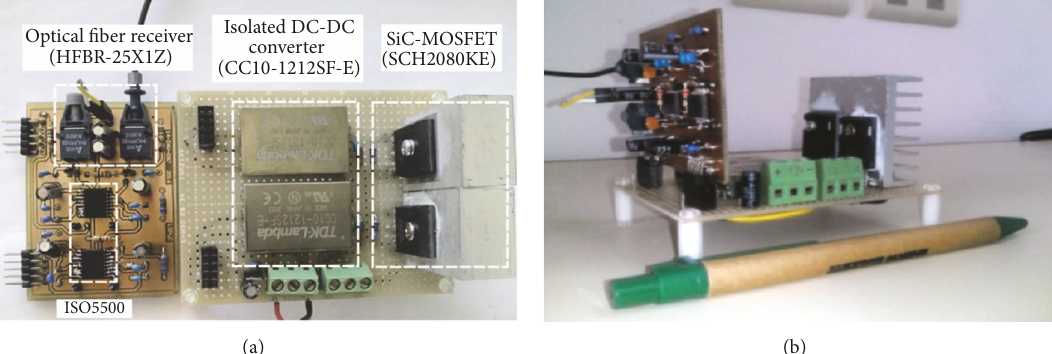
Figure 4: Images of the Bi-Sw PCB board. (a) Electronic boards for the Bi-Sw, buffer and power module. (b) Final disposition of the Bi-Sw